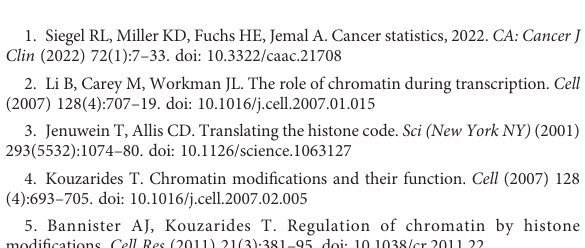
SUPPLEMENTARY TABLE 8 Expression of HLM regulators among the three geneClusters. a ns P